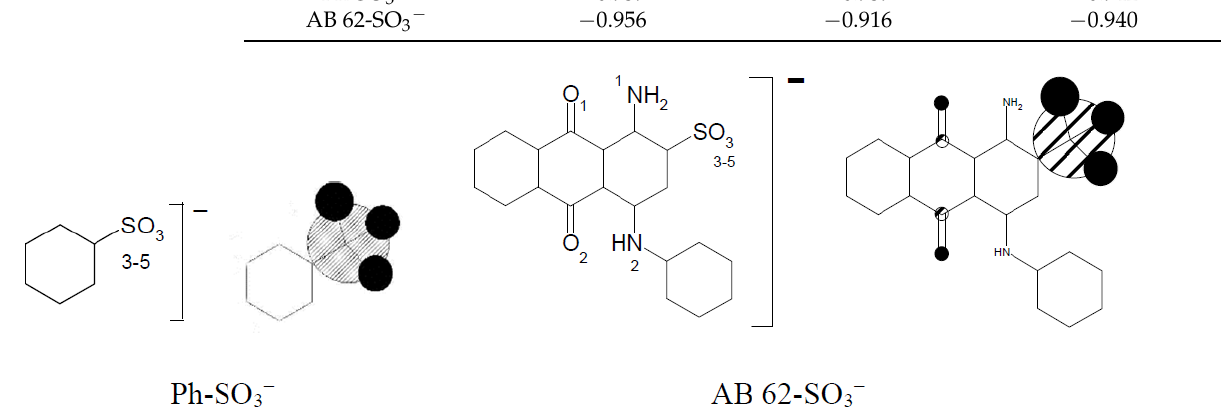
Figure 13. Example of graphical representation of the electron densities on oxygen atoms in sulfo group of benzenenesulfonic acid and AB 62 calculated for their anionic forms.